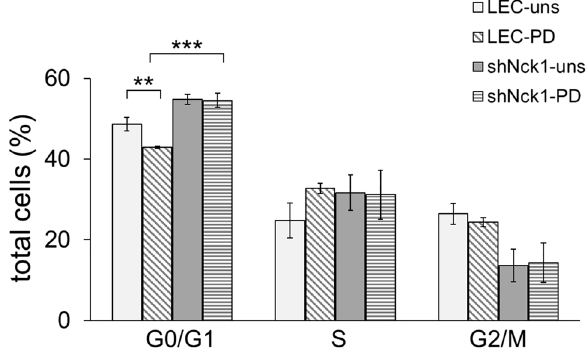
Figure 3. Nck1 knockdown disturbs cell cycle progression of LEC. Flow cytometry was used to detect cell cycle distribution. After 24 h treatment with 30 ng/ml PDGF-BB, a propidium iodide (PI)-stained cells were analyzed for the percentage of cell population at each phase of the cell cycle. The percentages of cells in G1, S, and G2/M is shown in graph representing the mean ± SEM. Data are representative of three independent experiments. **p < 0.01, ***p < 0.001. uns = unstimulated cells, PD = PDGF-BB-stimulated